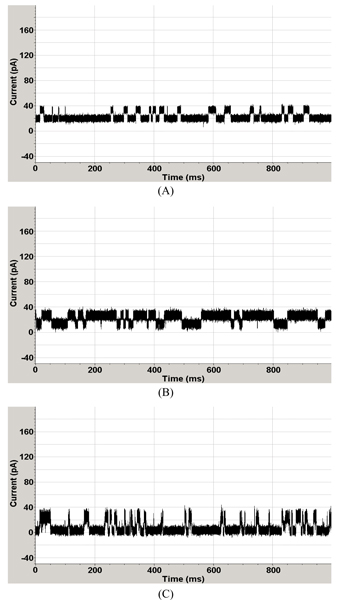
Single antibody, different blockade signals. (A) The lower-level (LL) blockade of this signal is not as deep as the others. (B) The LL blockade of this signal is about mid-way between those shown. (C) The LL blockade of this signal is the deepest, and difficult to eject with voltage reversal (requiring several attempts). The three signal classes represented by the above, as well as other, less common blockade signals (not shown), correspond to nanopore characterization of different epitopes of the antibody.